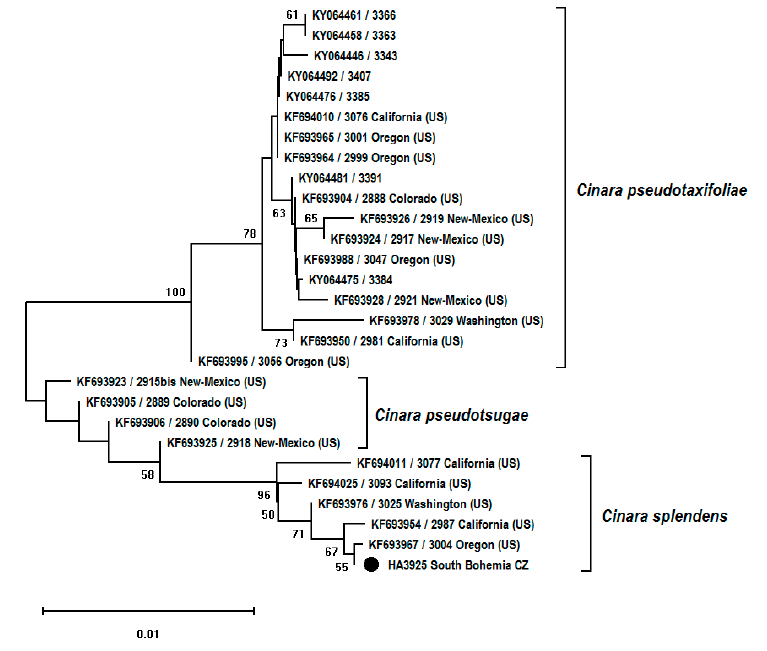
Figure 5. Neighbor-joining tree (p-distances, 1000 bootstrap replications) based on EF-1 α fragment (1024 bp) of species of the genus Cinara collected from Pseudotsuga spp. Bootstrap values over 50% are shown next to branches. The sample from the Czech Republic is marked with black circle.